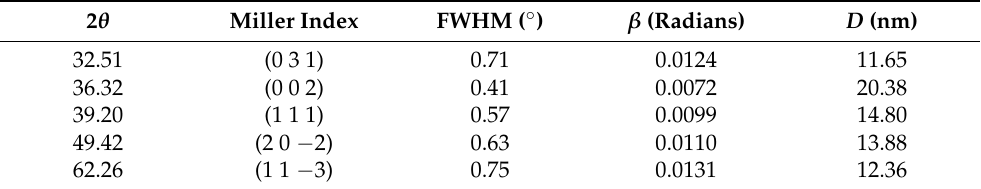
Table 1. Particle size distribution based on Debye–Scherrer’s